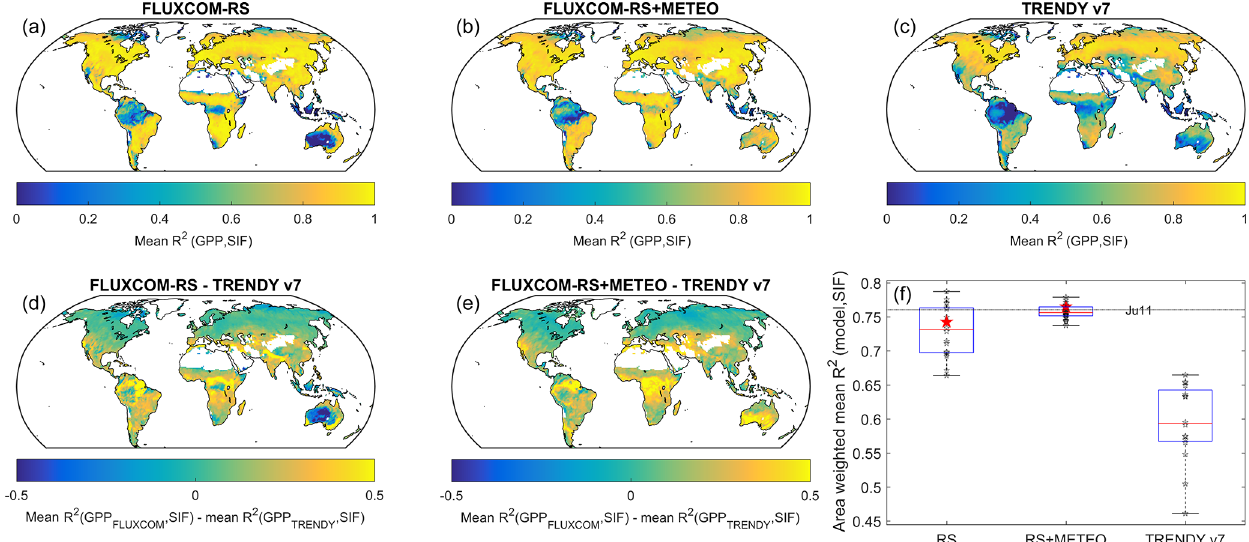
Figure 5. Consistency of seasonal GPP variations from FLUXCOM and TRENDY with SIF from GOME-2. Maps in (a, b, c) show the mean R 2 between mean seasonal cycles for the period 2008–2010, averaged across all respective ensemble members. Difference maps in (d, e, f) emphasize where FLUXCOM shows better (positive value) and worse (negative value) consistency with SIF than TRENDY and are based on the maps in the top row. The spatially averaged R 2 values for the different ensembles are summarized in (f) . The box plots show the distribution of individual ensemble members (open black stars). The filled red star presents the value of the ensemble product (not available for TRENDY). The estimate of Ju11 is plotted as a horizontal